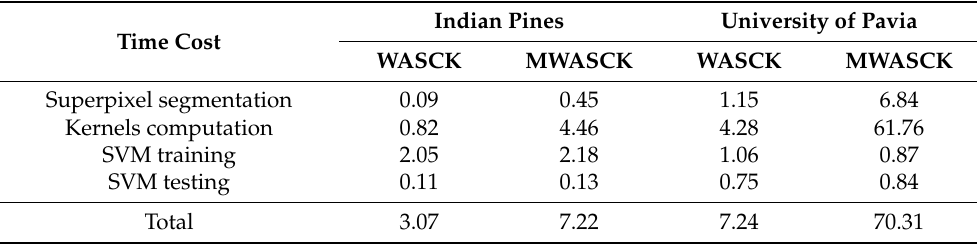
Table 6. Time costs (in seconds) of the WASCK and MWASCK on two